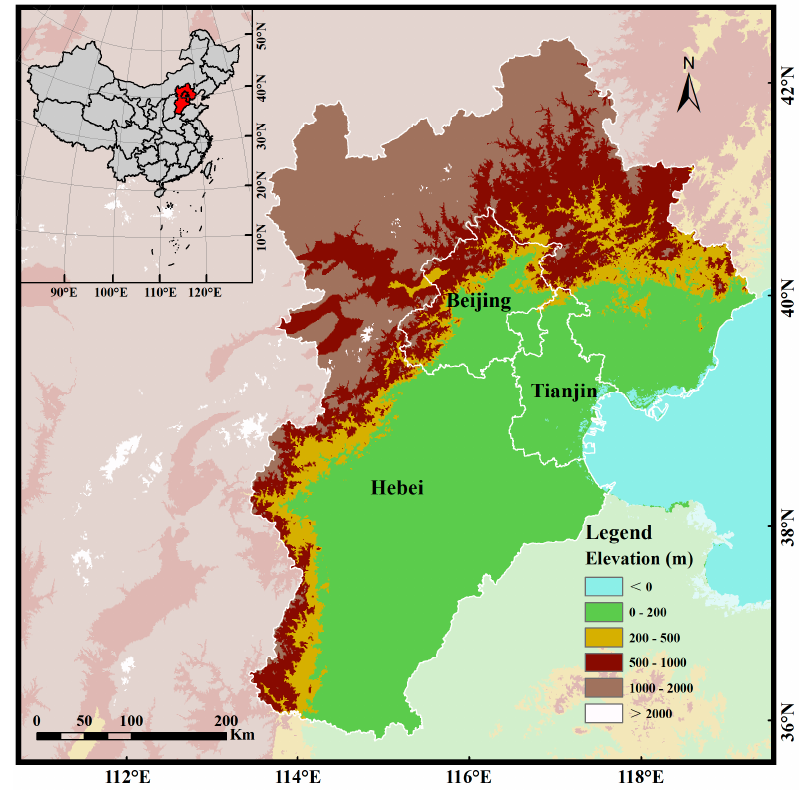
Figure 1. The location of the study area.